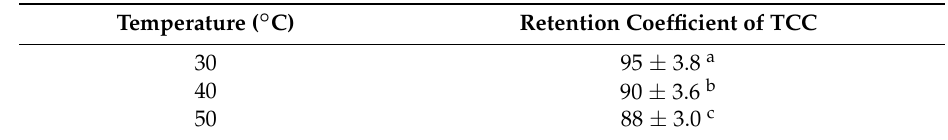
Figure 16. Effect of temperature on permeate flux of gac oil (TMP = 3 bars; Membrane pore size = 100 nm). Table 7. Effect of temperature on retention coefficient of TCC in